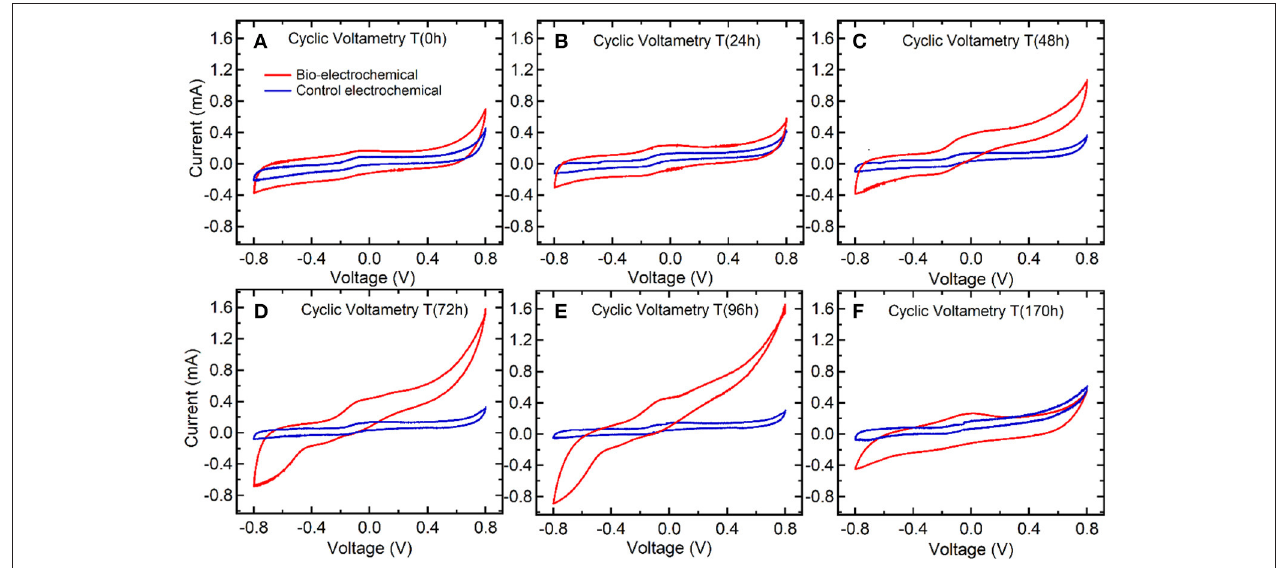
FIGURE 4 | Cyclic voltammograms at different time intervals during bio-electrochemical (red line) and control electrochemical operation (blue